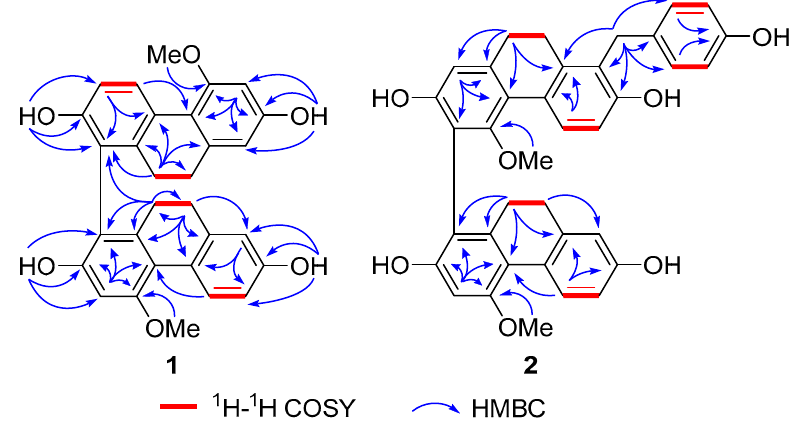
Figure 2. Key 1 H– 1 H COSY and HMBC correlations of compounds 1 and 2 .